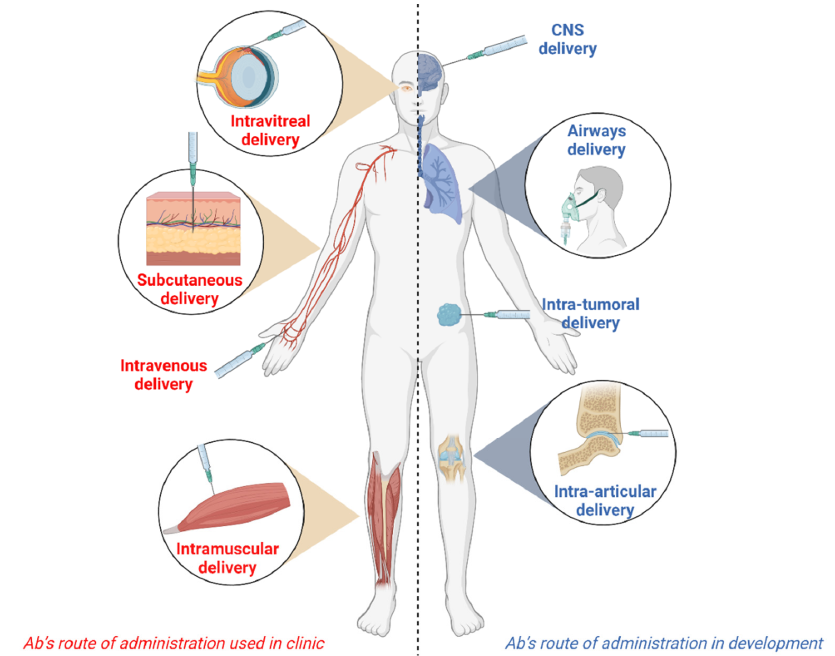
Figure 1. Routes of administration for therapeutic antibodies in Humans.